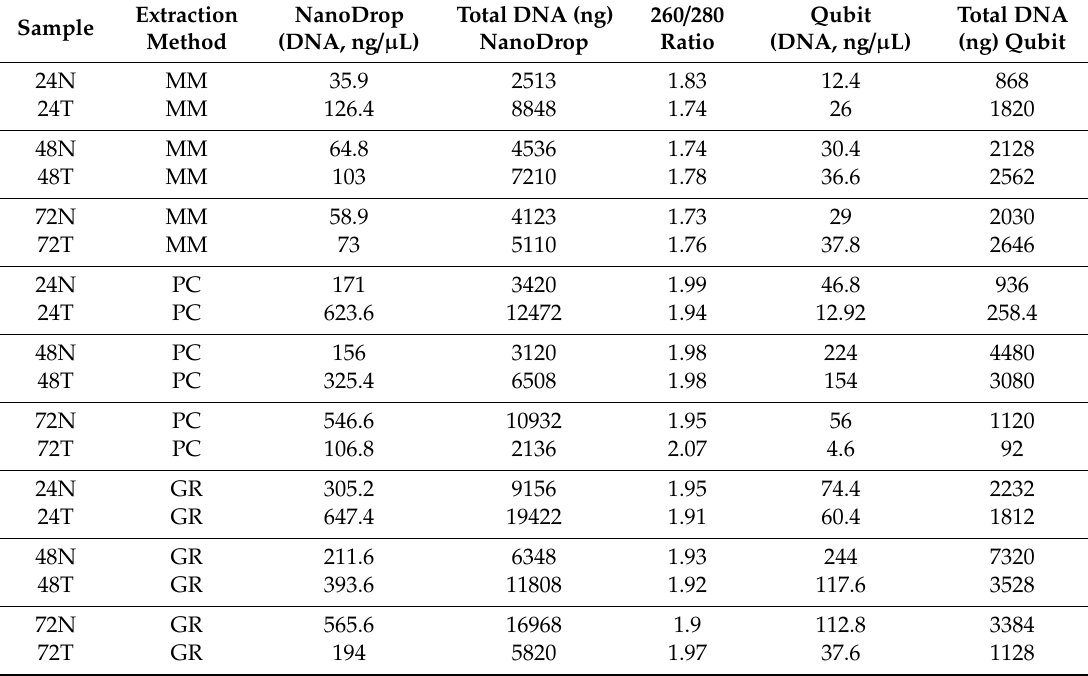
Table 1. Quantification of normal vs. tumoral DNA extracted after 24 h, 48 h or 72h of formalin fixation by three di ff erent manual recovery systems using spectrophotometric (NanoDrop) and fluorometric (Qubit) assays.